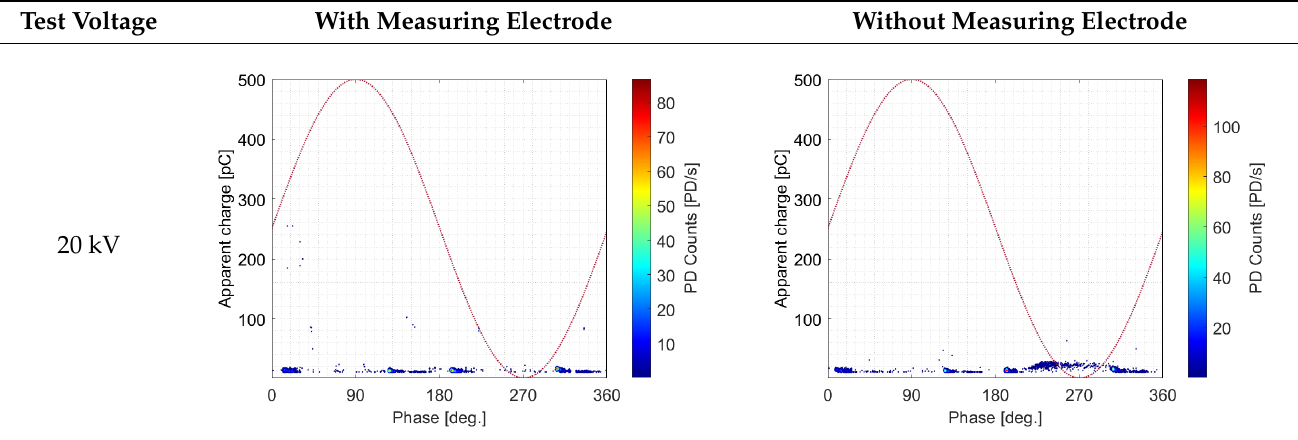
Figure 8. Values of apparent charge Q depending on the test voltage U p for a cable with the installed corona rings registered with the ME and HF methods: ( a ) Q wtd , ( b ) Q peak , ( c ) Q avg . Table 3. PRPD images recorded by the ME